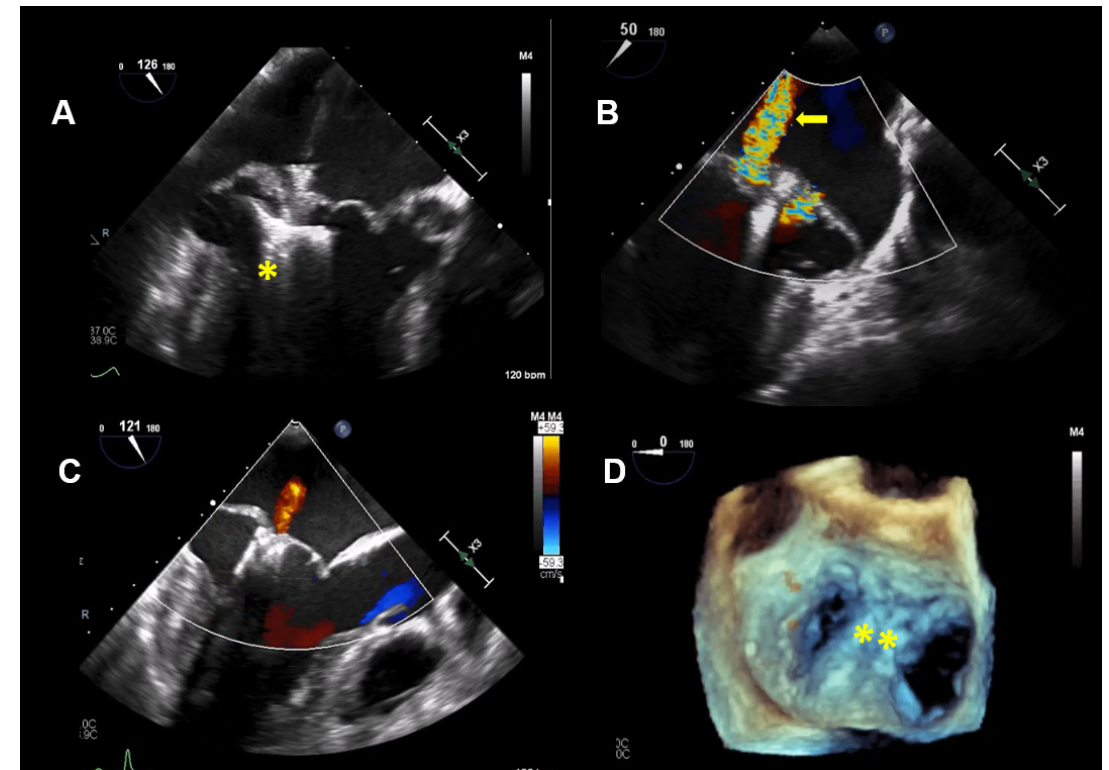
Figure 4. Case 2: Procedural transesophageal echocardiographic imaging during MitraClip XTR (Abbott Vascular, North Chicago, Illinois, USA) implantation. ( A ) The first MitraClip XTR (yellow asterisk) is positioned below the mitral leaflets with opened Clip arms. ( B ) Residual mitral regurgitation (MR) after implantation of the first Clip is marked with a yellow arrow. ( C ) After positioning of the second Clip, only mild MR is present. ( D ) The 2 MitraClip XTR devices (yellow asterisk), which create a double orifice, are seen in a 3D enfaced view.